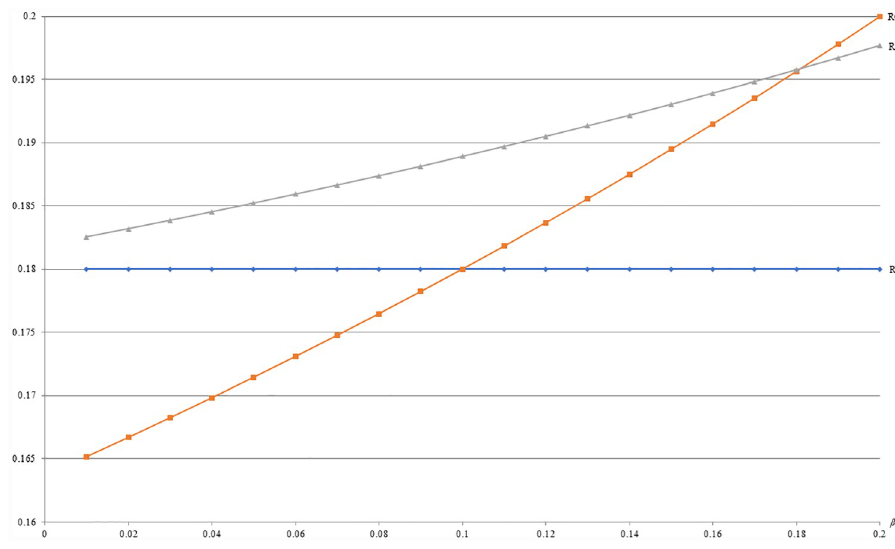
Fig 13. A comparison of revenues between IB, GB and MIX with respect to β